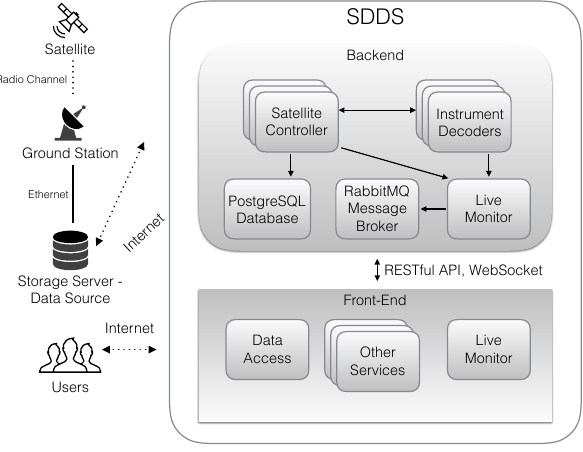
Figure 1. The architectural overview of